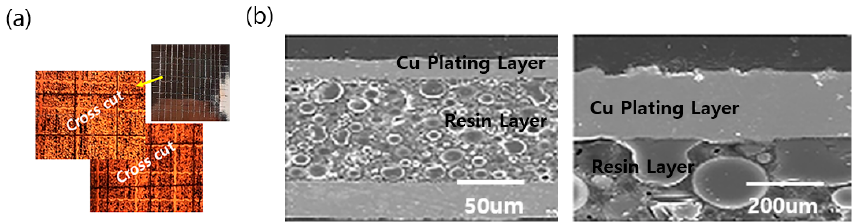
Figure 8. Adhesive strength evaluation method: ( a ) Example photo of Crosscut test; ( b ) SEM micro- scope between resin and Cu interface.